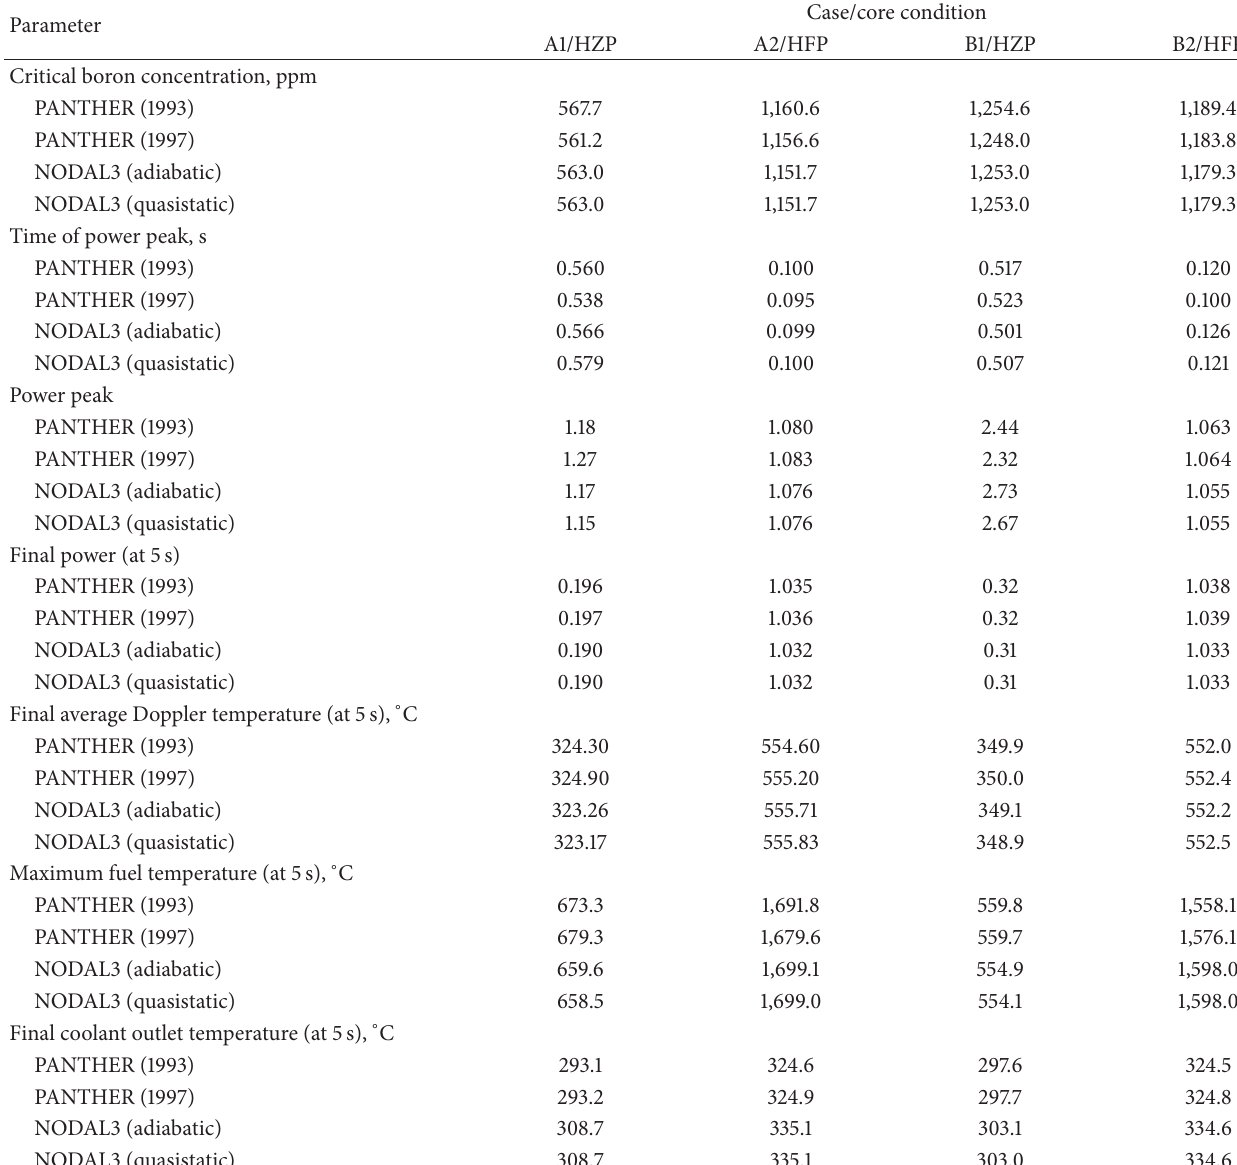
Table 2: The calculation results of NODAL3 code for steady sate and transient